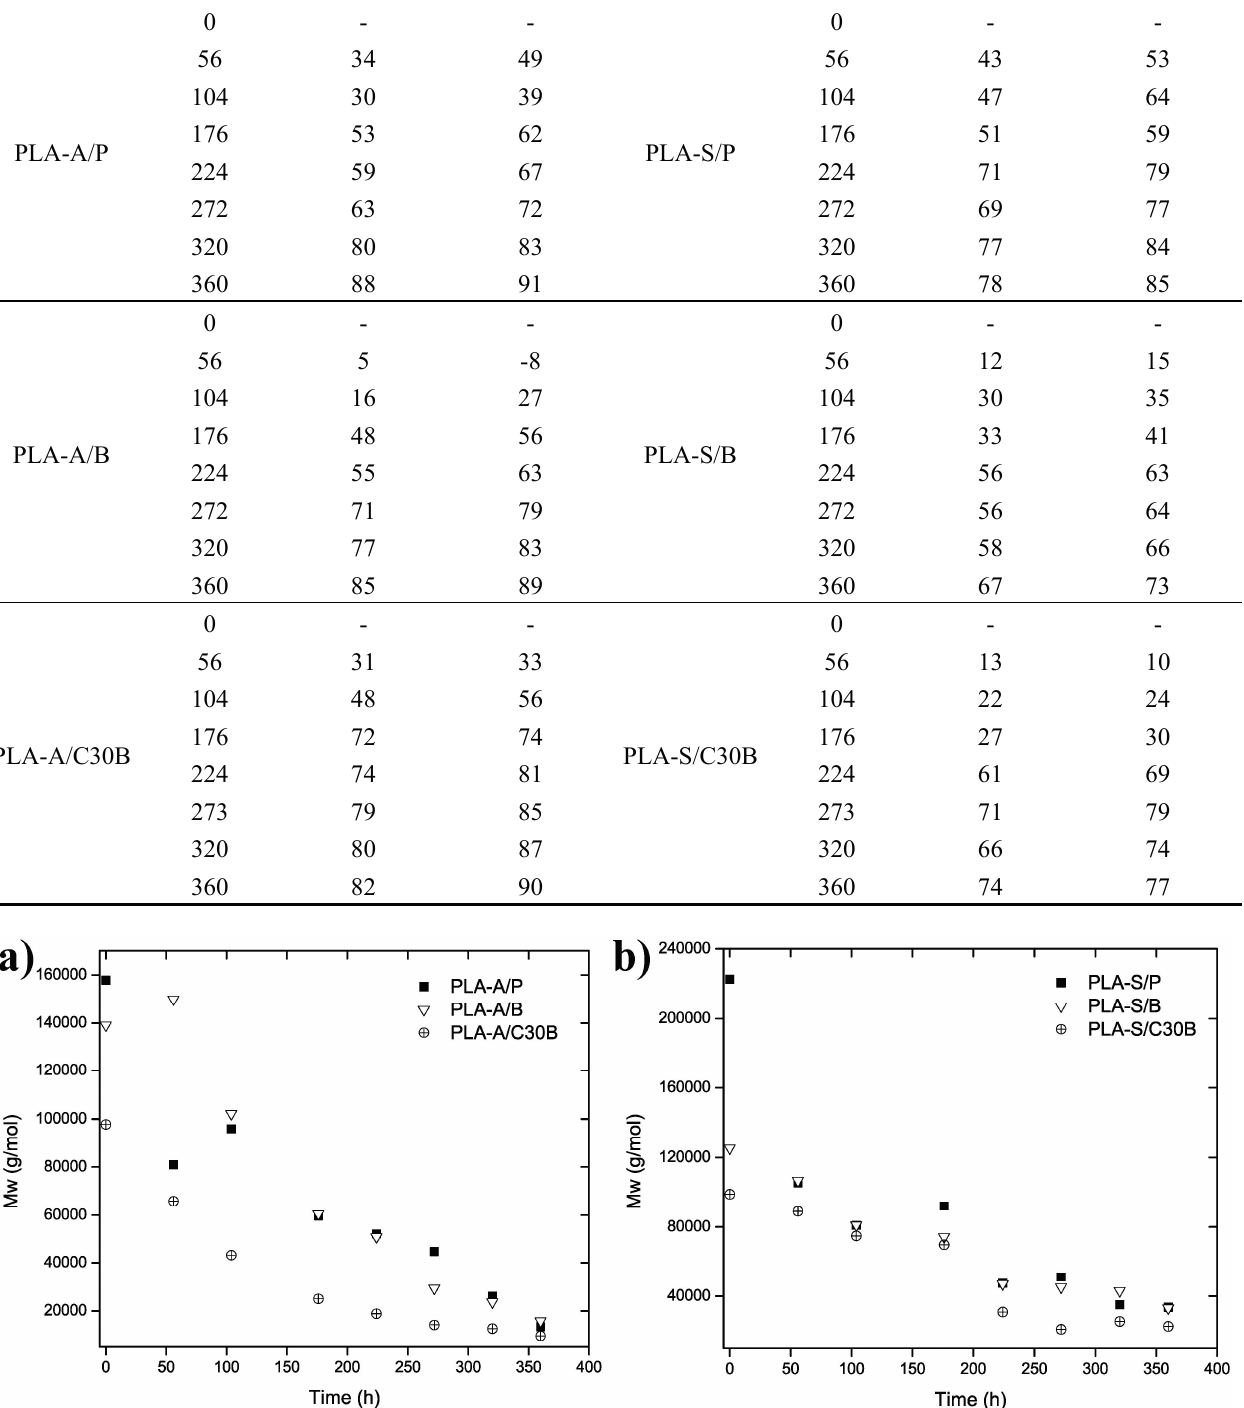
Table 3. Percentages of M n and M w degradation of samples under artificial weathering. Sample